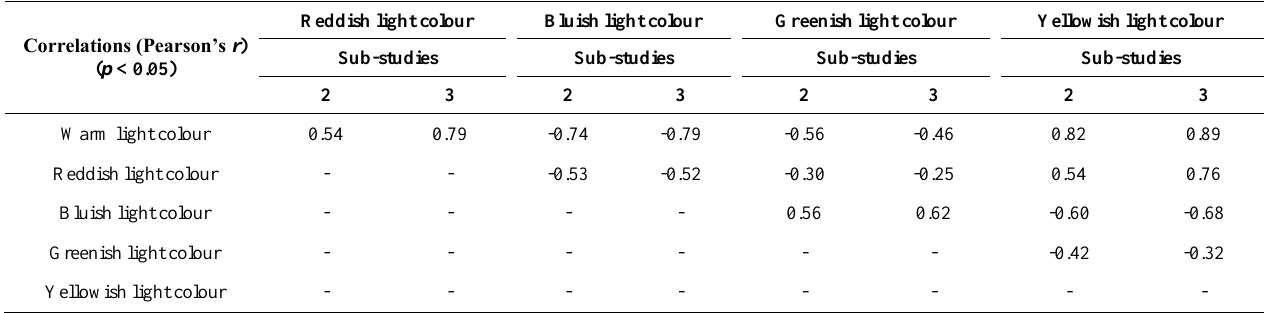
Table 3. Correlations for concepts related to light colour, results from tests performed in sub-studies 2 and 3 (significant level p < 0.05) Correlations (Pearson’s r ) ( p < 0.05)